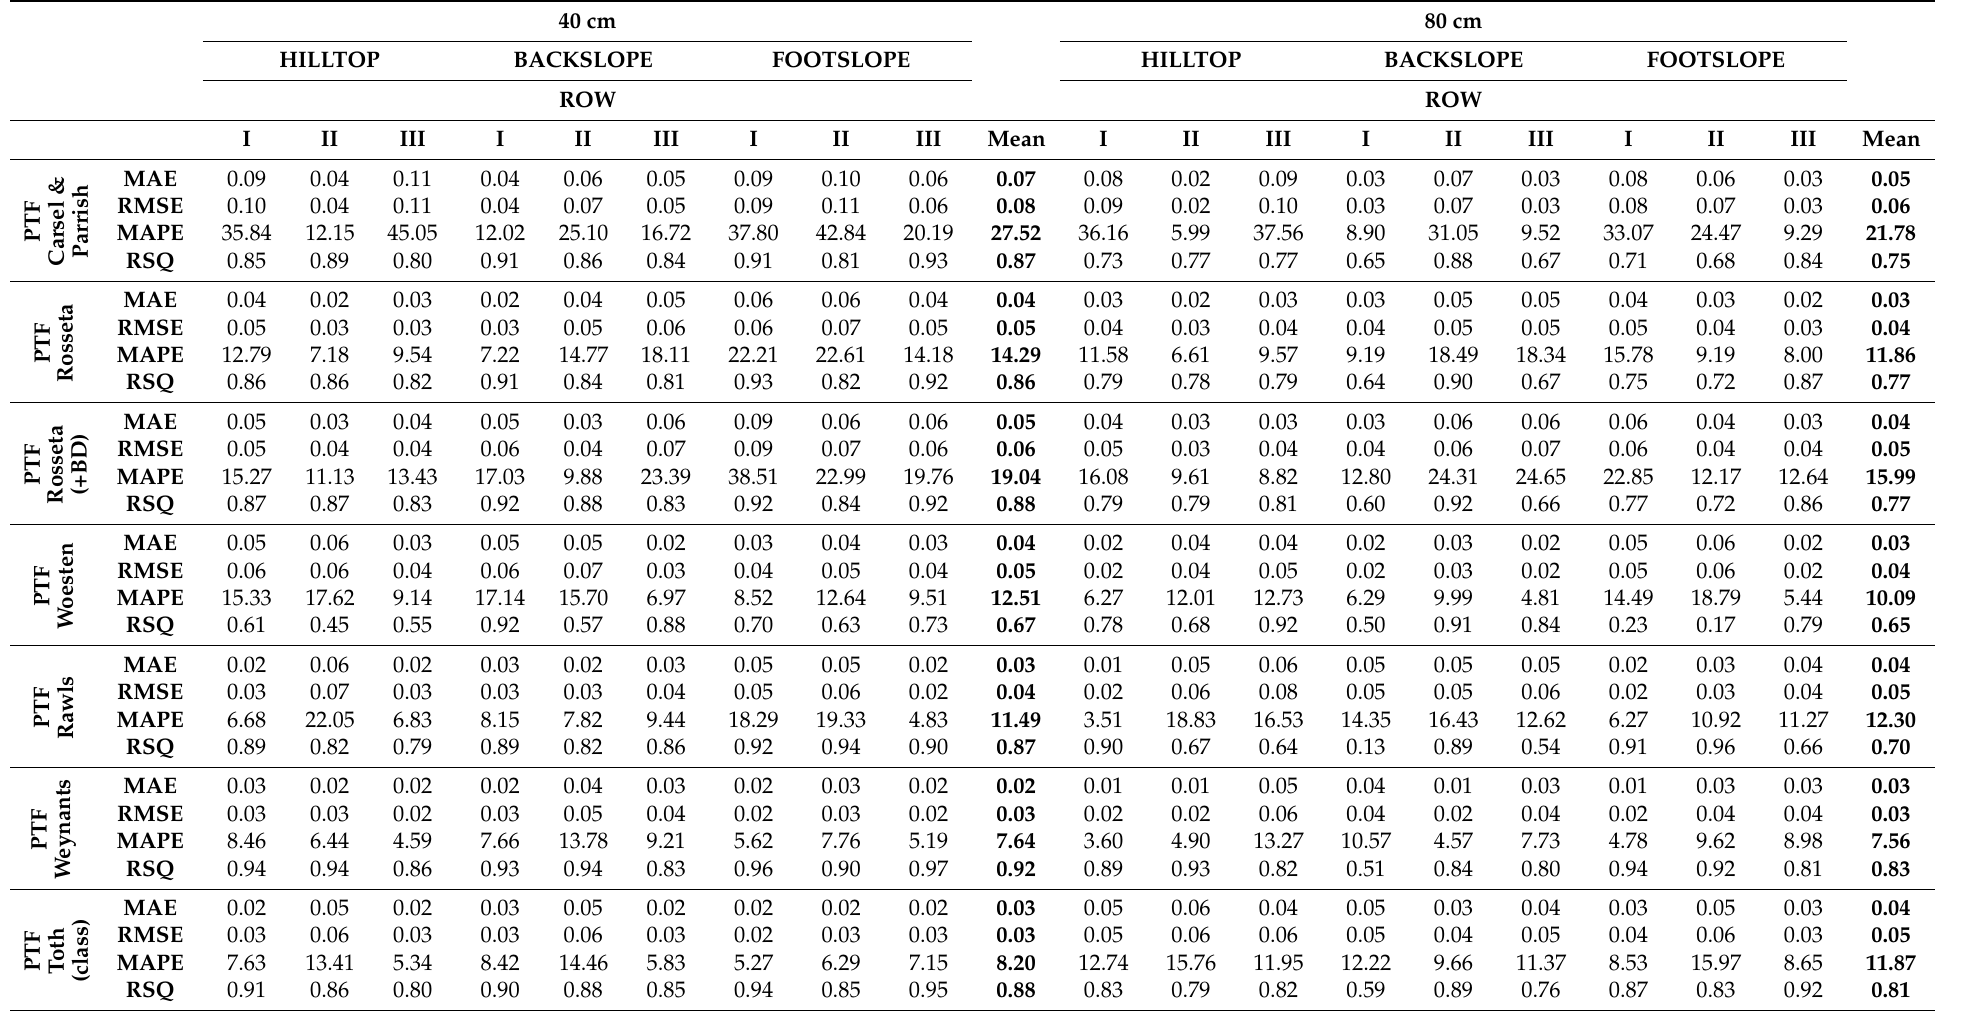
Table 3. Mean absolute error (MAE), root mean square error (RMSE), mean absolute percentage error (MAPE) and coefficient of determination (R 2 ) for simulated SWC (individual PTFs, PTF model ensemble, laboratory data, and laboratory + field data) vs. observed SWC at 40 and 80 cm soil depth in 2021 at the SUPREHILL